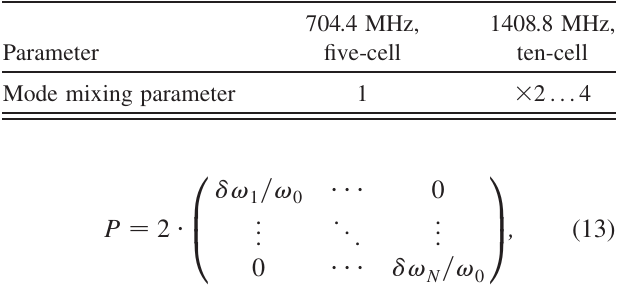
TABLE XV. Sensitivity for bad field profiles (lower HOM damping) concerning manufacturing tolerances.